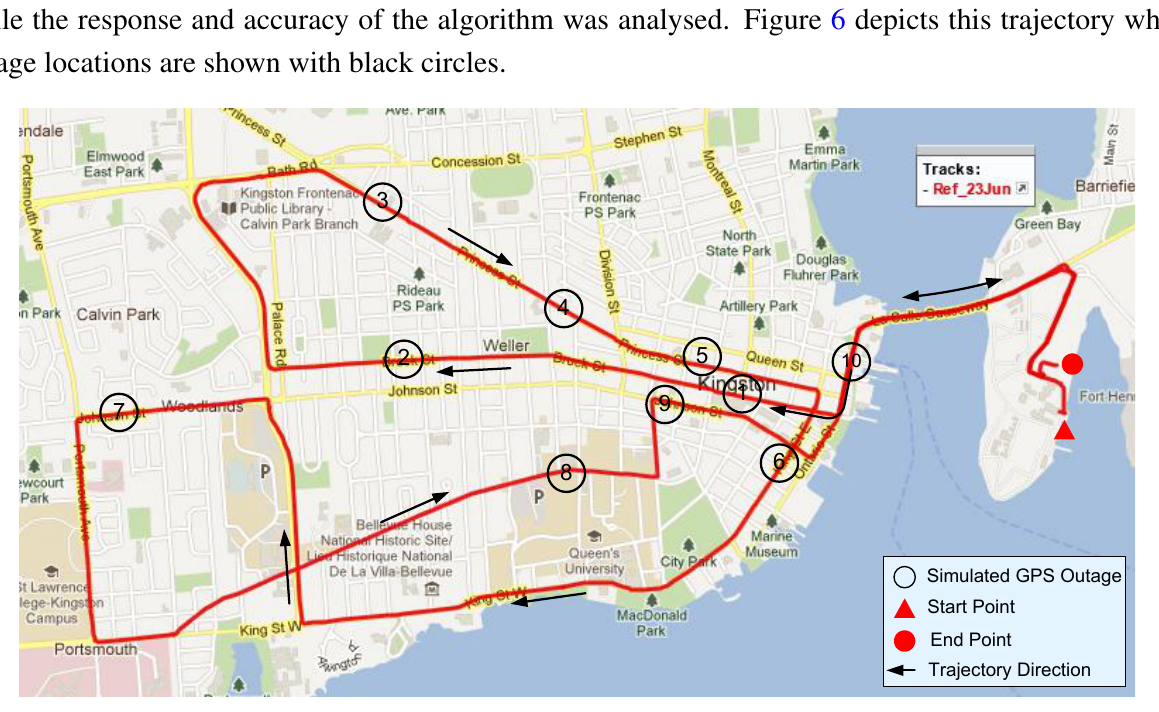
Figure 6. Test trajectory in Kingston downtown, ON,